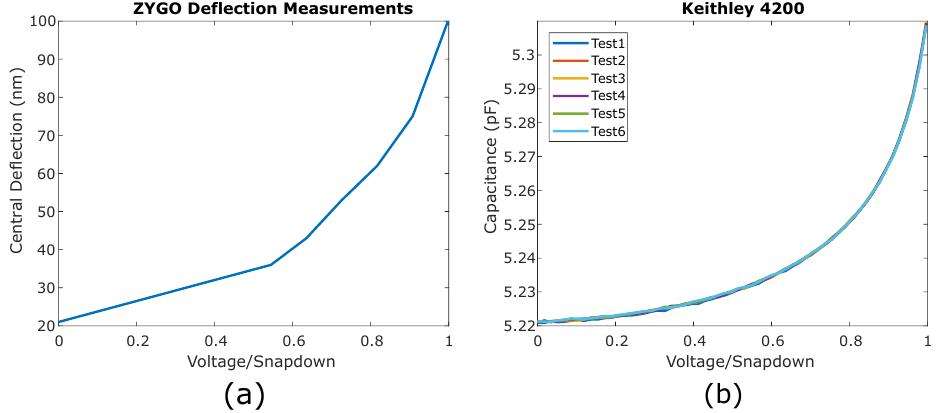
Figure 10. Static tests. ( a ) Deflection versus voltage changes measured by an optical profilometer. ( b ) Capacitive versus voltage changes measured with a semiconductor characterization system. Both graphs are normalized to the pull-in voltage of the CMOF mirror, which is 29.6